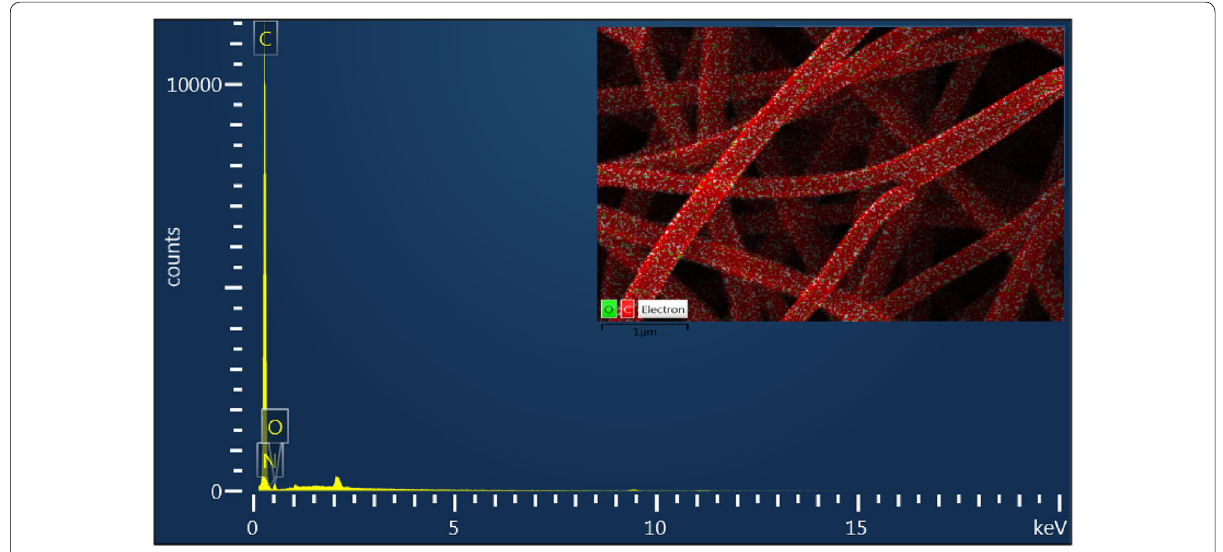
Fig. 7 The EDS spectrum of the sample 60-ANF-HNO3-TEPA (inset: EDS layered image)